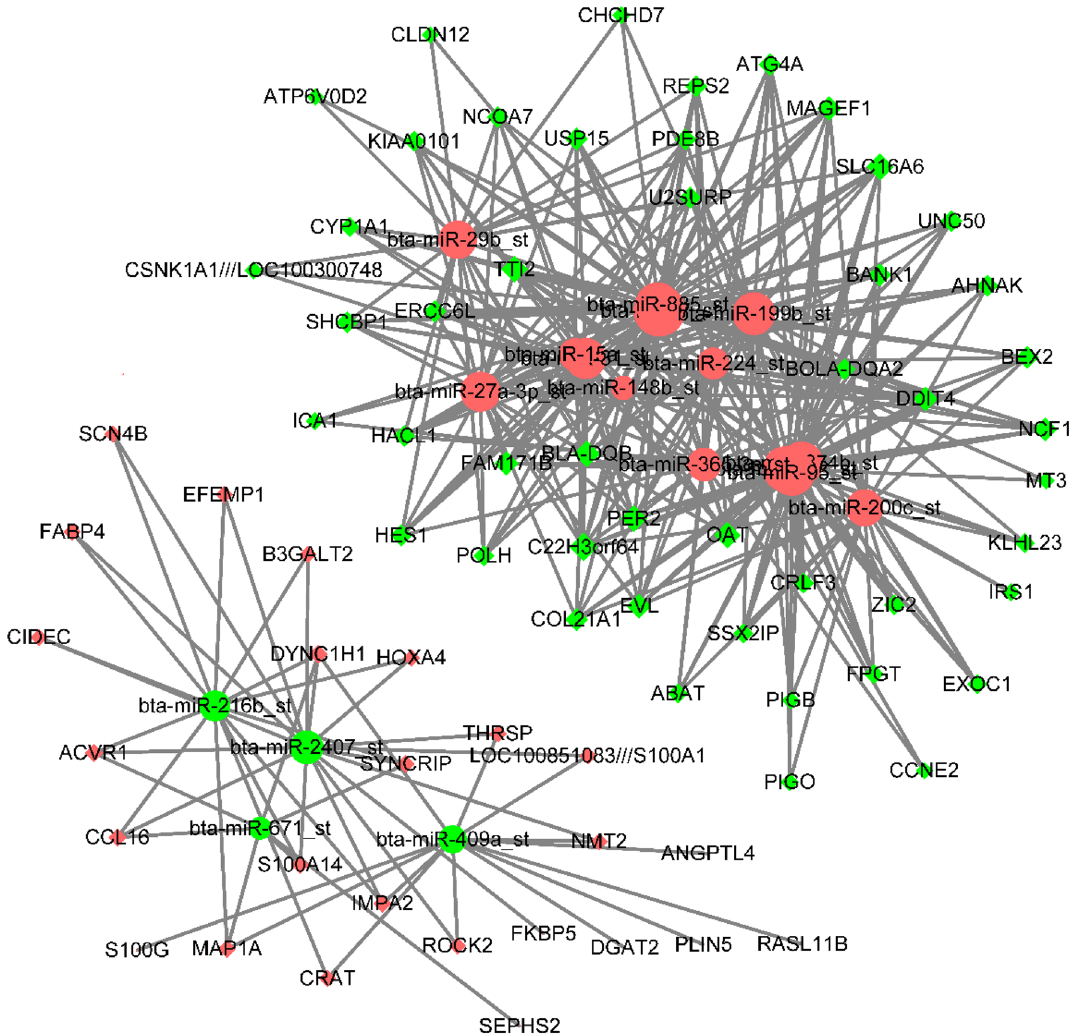
Figure 2. Interaction networks of miRNA and mRNA. Red and green indicate up- and down-regulation, respectively; round and diamond indicate regulated mRNA and miRNA, respectively; The significant round indicated that genes were